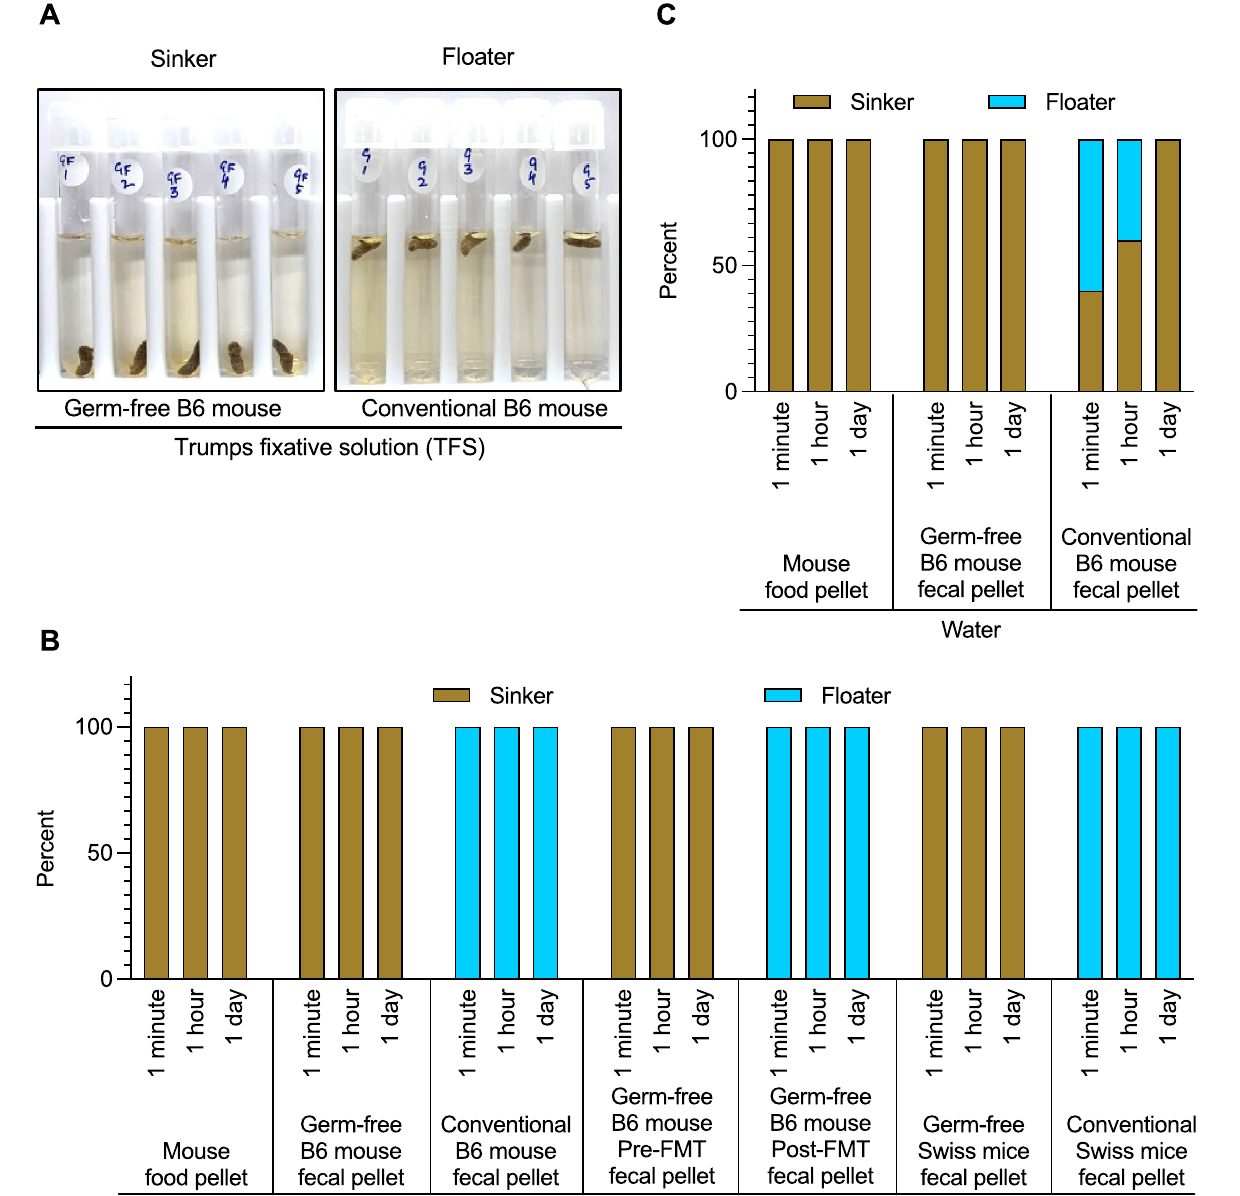
Figure 6. Levô in fimo test. ( A ) Representative levô in fimo test (LIFT) results of fecal pellets showing ‘sinkers’ and ‘floaters’ from germ-free and conventional in TFS. Floating and sinking feces indicates positive and negative LIFT results respectively. ( B ) LIFT efficacy over 24-h time period for different fecal pellets in water and ( C ) TFS for fecal pellets from germ-free and various gut-colonized mice. Bar plot summarizing LIFT results are presented. A minimum of 5 individual fecal pellets were tested per group of 5 mice